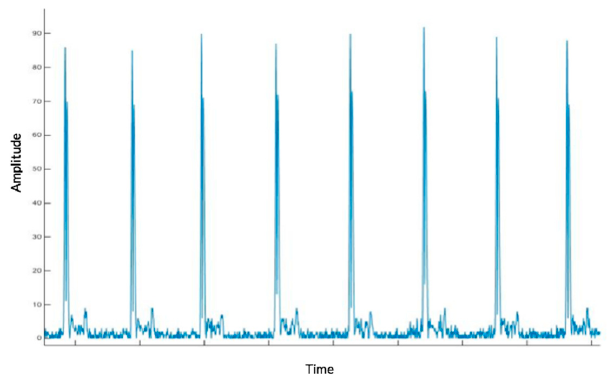
Figure 13. Electrocardiogram First Derivation.